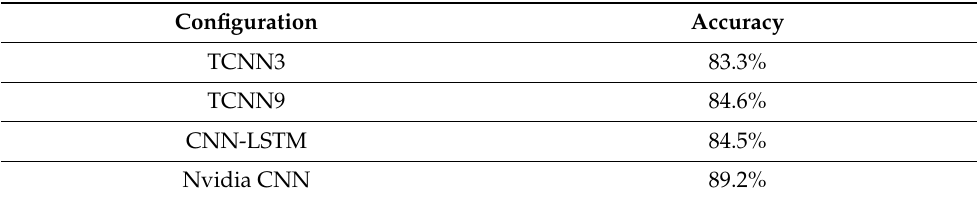
Table 3. Accuracy comparison with previous literature proposed